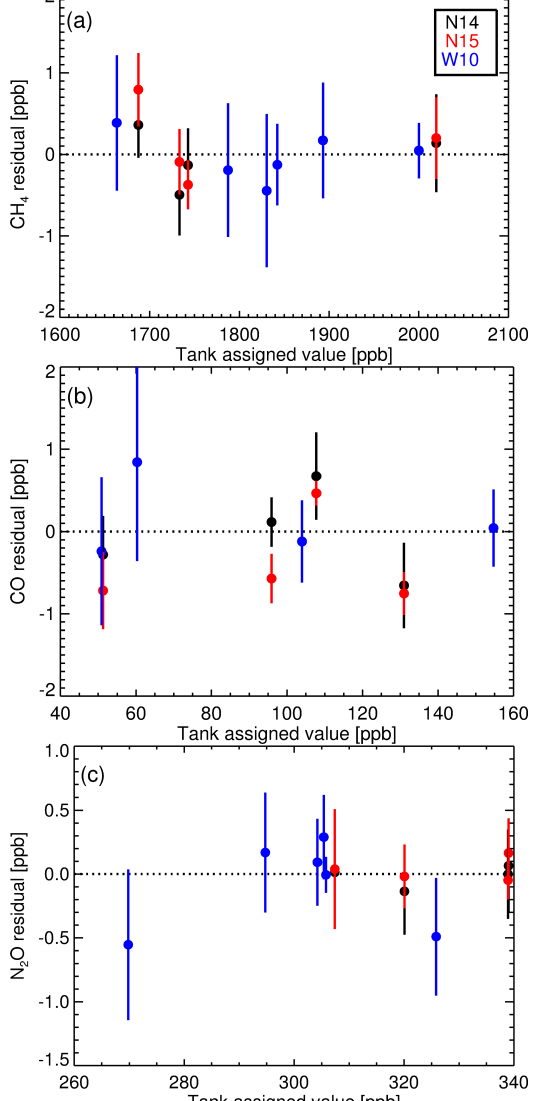
Figure 10. (a) The difference between calibrated CH 4 measure- ments of the three multi-tank suites (N14 black, N15 red and W10 blue) against assigned tank values with 1 σ uncertainty bars. The coloured diamonds are the assigned WS dry mole fraction used to calibrate each respective set of suite measurements using the scale factor method. The dashed-dotted lines are the estimated concentration-dependent biases (CDB) arising from applying the scale factor method, for each measurement suite. The grey shaded area indicates the typical baseline concentration range at Lauder. Panels (b) and (c) show the same as (a) but for CO and N 2